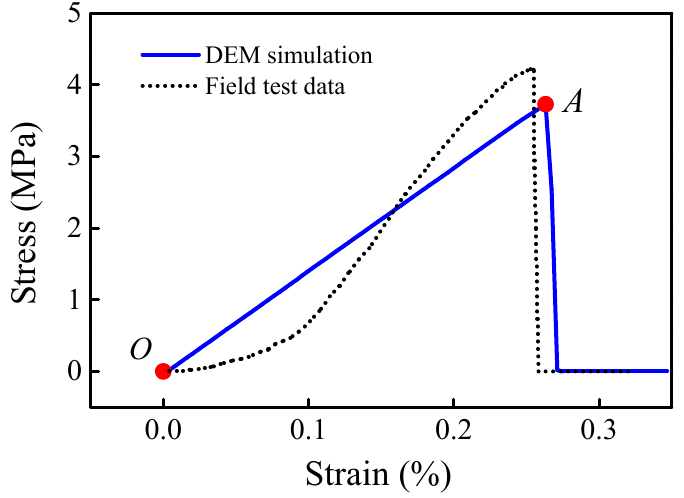
Figure 5. Stress–strain curve of sea ice under a uniaxial compression test.